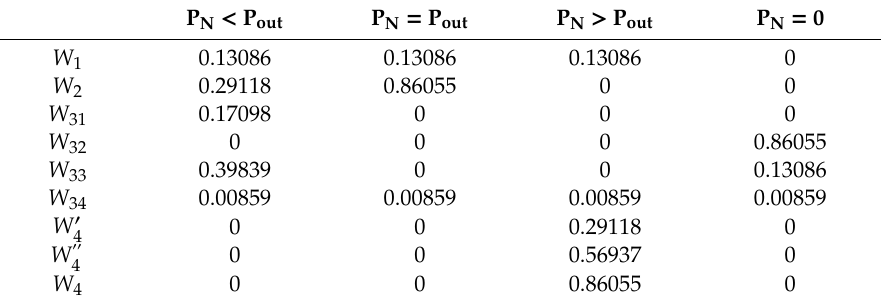
Table 6. Evaluation results of weight parameters at di ff erent operational